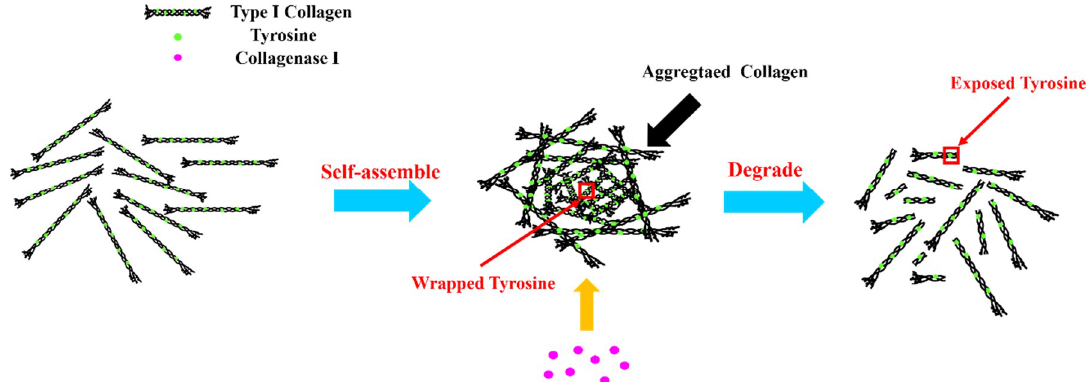
Figure 2. The interaction mechanism of type I collagen and collagenase I.